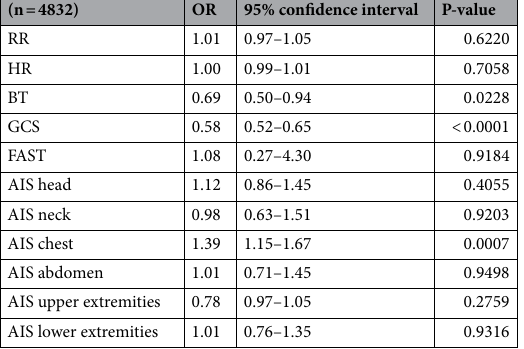
Table 6. Multivariate analysis results of factors associated with child outcomes (5–18 years). AIS abbreviated injury scale, BT body temperature, CI confidence interval, GCS Glasgow Coma Scale, OR odds ratio. Logistic regression